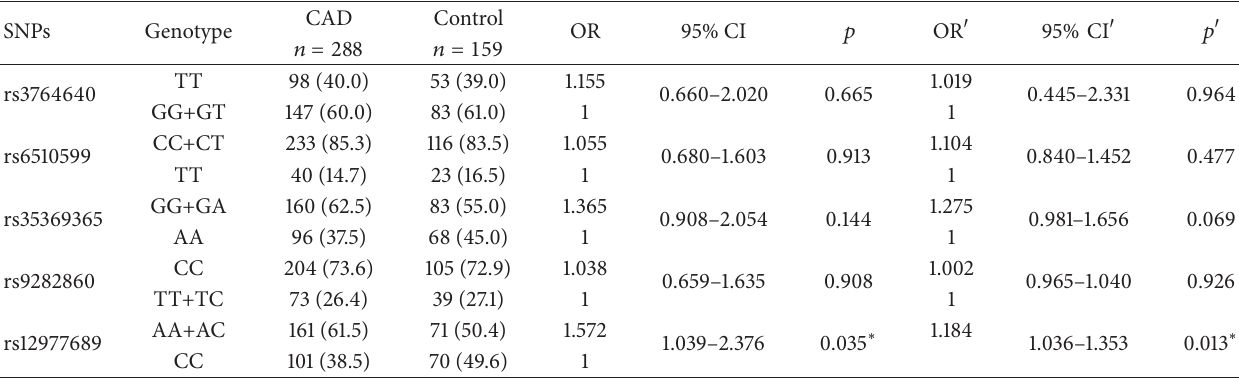
Table 3: Association between CAD and SNPs at STK11 locus in different genetic model.